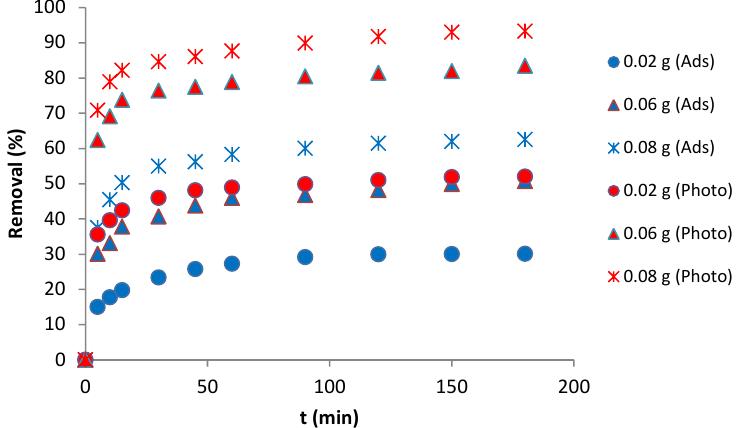
Fig. 5. The effect of adsorbent dosage on the adsorption and photodegradiation of MB on 5-SA-TiO2 (initial concentration 200 mg/L, pH = 6, T=298 K and contact time 180